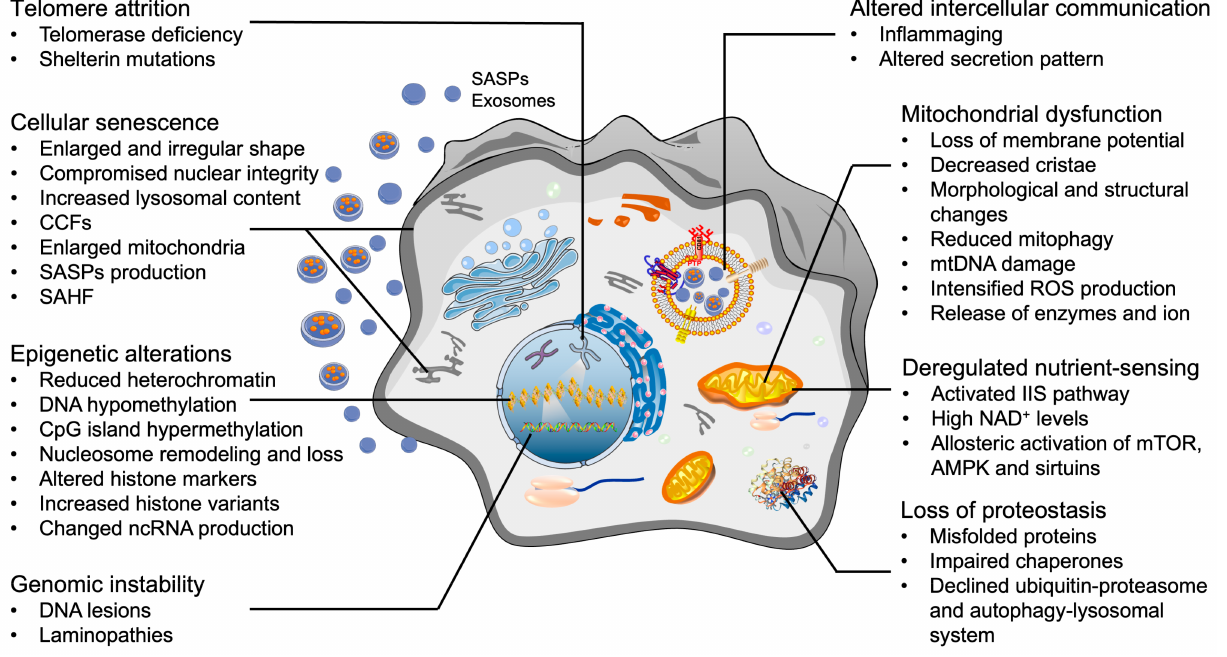
Figure 1. Cellular hallmarks of aging that are also present in OA chondrocytes. SASPs: senescence- associated secretory phenotypes; ROS: reactive oxygen species; CCF: cytoplasmic chromatin frag- ments; SAHF: senescence-associated heterochromatin foci; mTOR: mammalian target of rapamycin; AMPK: AMP-activated protein kinase; NAD: nicotinamide adenine